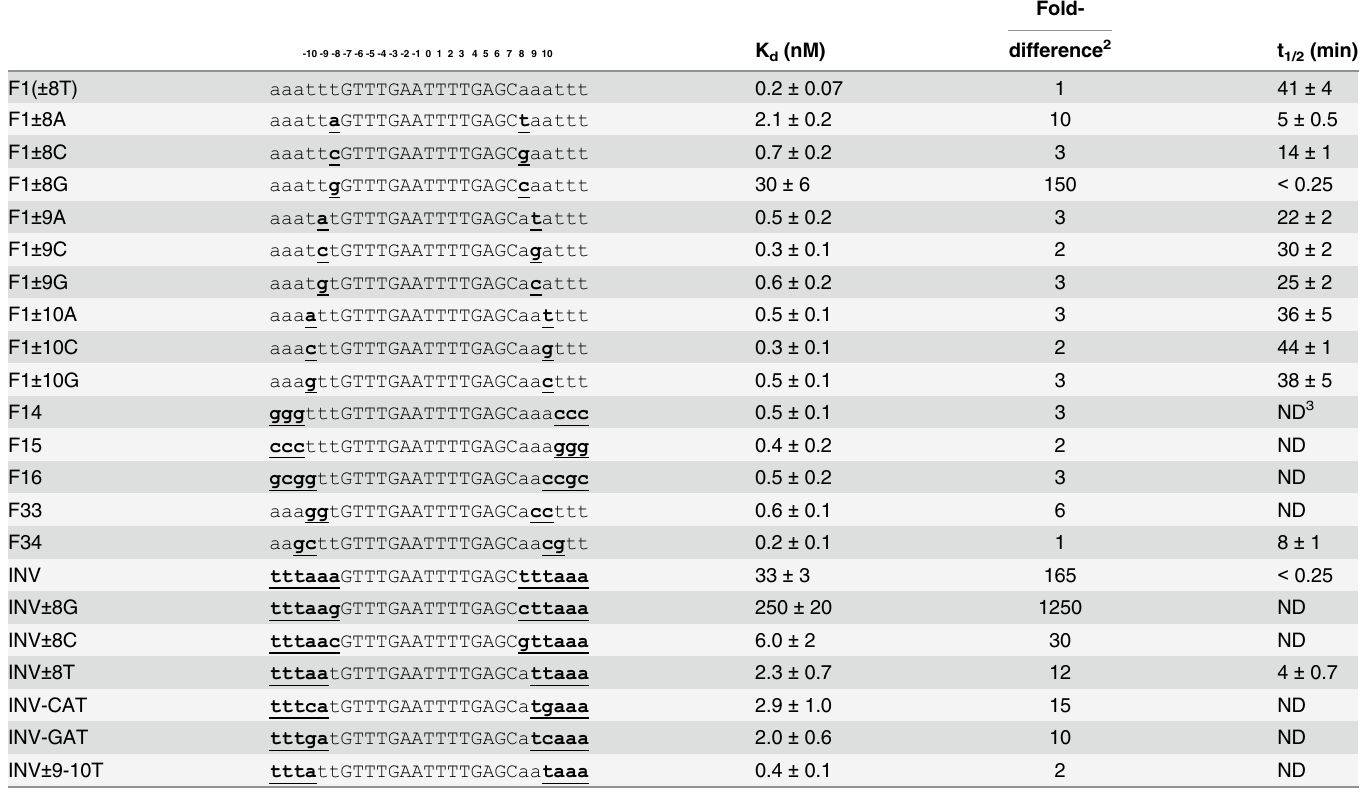
Table 2. Effects of flanking DNA substitutions on Fis-DNA binding affinity and complex stability 1